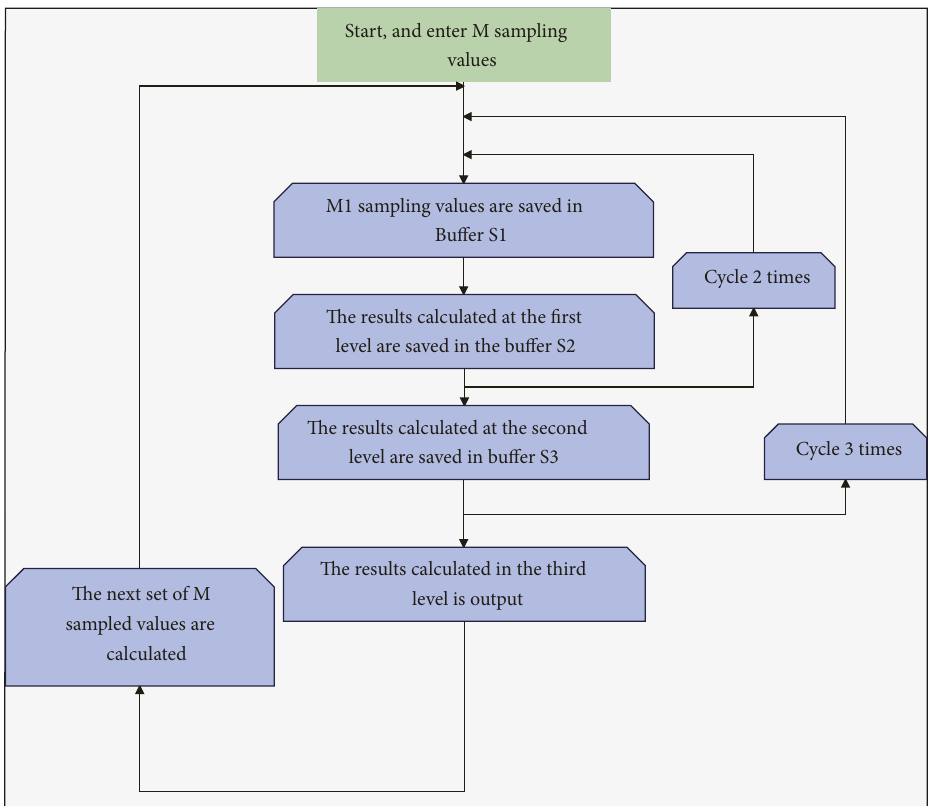
Figure 5: Flowchart of the three-stage extraction